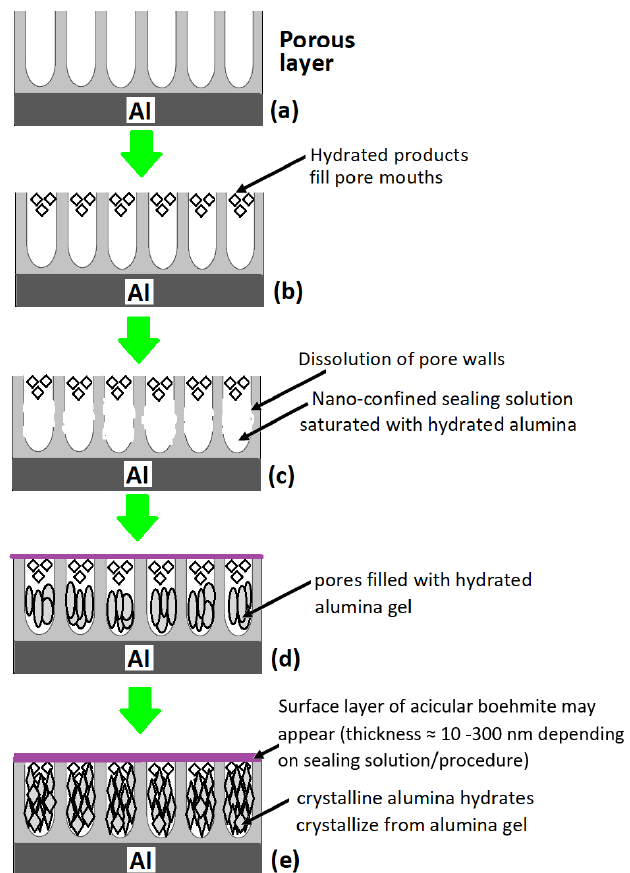
Figure 1. Structure of the anodized layer on aluminum prior to sealing and changes that occur during sealing; ( a ) anodized aluminum prior to sealing, ( b ) pore mouths filled with hydrated products, ( c ) dissolution of pore walls, ( d ) precipitation of hydrated alumina gel in pores and emergence of surface layer of acicular boehmite, and ( e ) crystallization of crystalline alumina from alumina gel.